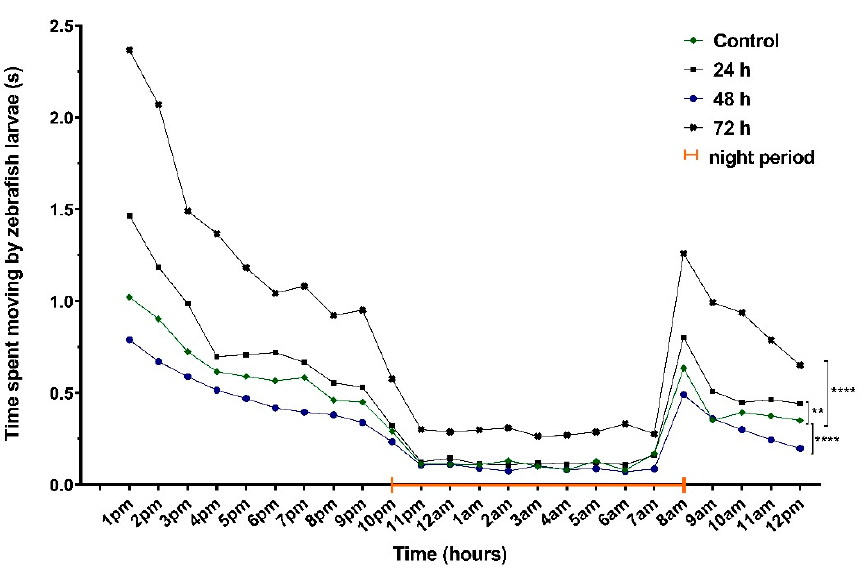
Figure 5. Results of time spent moving parameter (active status) of 6-day-old larvae recorded during 24 h ( n = 30). Group 1, control; Group 2, group exposed for 24 h to VPA; Group 3, group exposed for 48 h to VPA; and Group 4, group exposed for 72 h to VPA. The data is represented as average ± SEM. Anova and Tukey post-hoc tests, p < 0.05 was considered to be significant. The experimental groups were compared to control group, where ** p < 0.01; **** p < 0.0001.